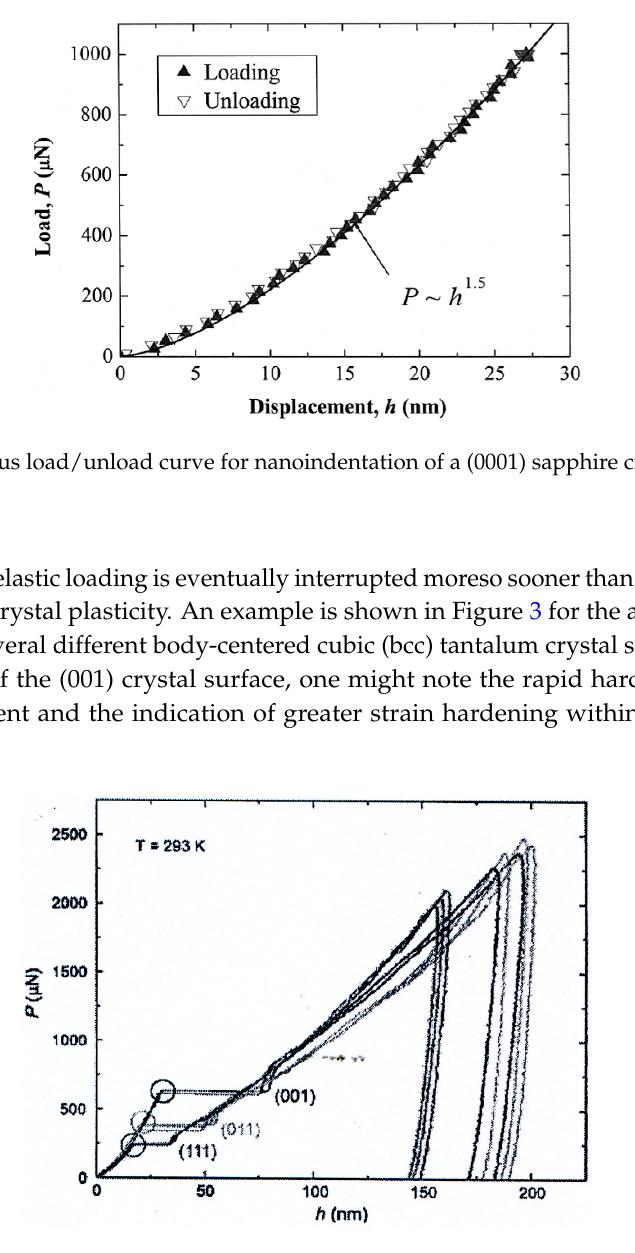
Figure 3. Nanoindentation load–penetration curves obtained with impressing a (rounded point) Berkovich tri-pyramidal indenter into various tantalum (111), (011) and (001) crystal surfaces [13].